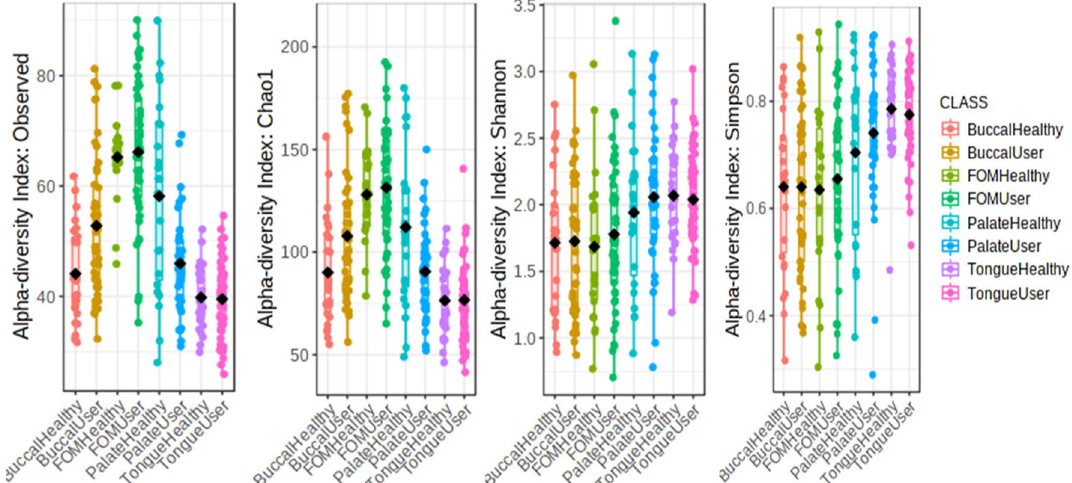
Figure 2. α diversity variation between four oral mucosal locations (buccal, floor of mouth (FOM), palate and tongue) in users and non-users of Toombak. 2. Shannon index ( p = 0.00076), Richness or Observed ( p = 3.6849e−34) and Simpson’s index ( p = 3.3603e−08) were all significant between groups. Richness was found to be lowest for tongue microbiome but similar in the remaining locations. The tongue and palatal mucosa (Simpson’s index community diversity closest to 1) show the closest